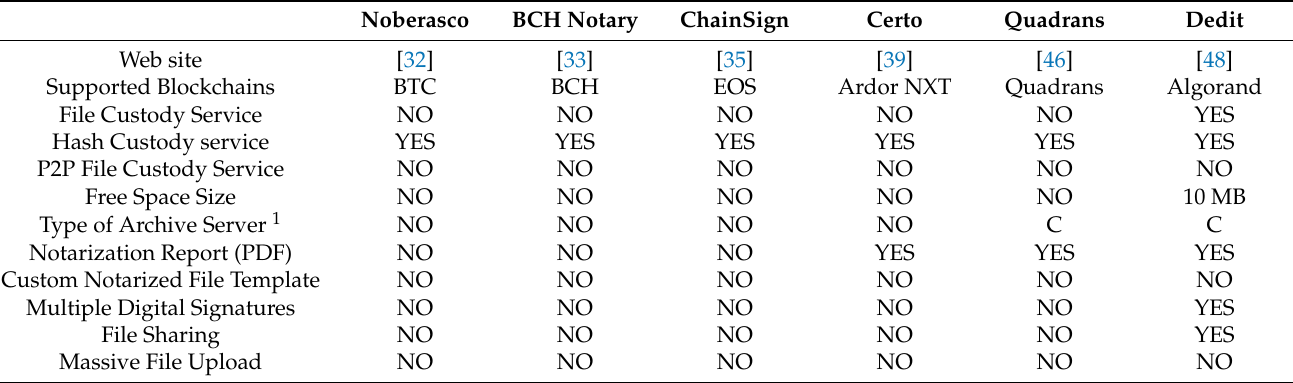
Table 1. Notarization apps